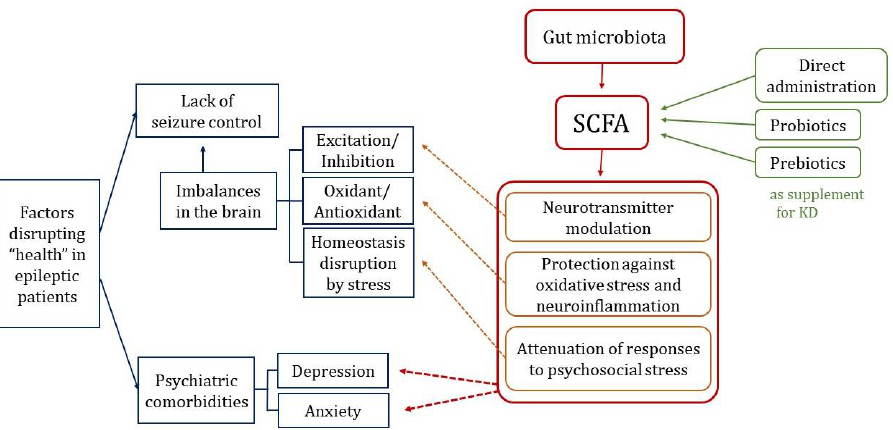
Figure 1. Overview of the impact of short chain fatty acids in factors disrupting the “health” of patients with epilepsy. Short chain fatty acids (SCFAs); ketogenic diet (KD).